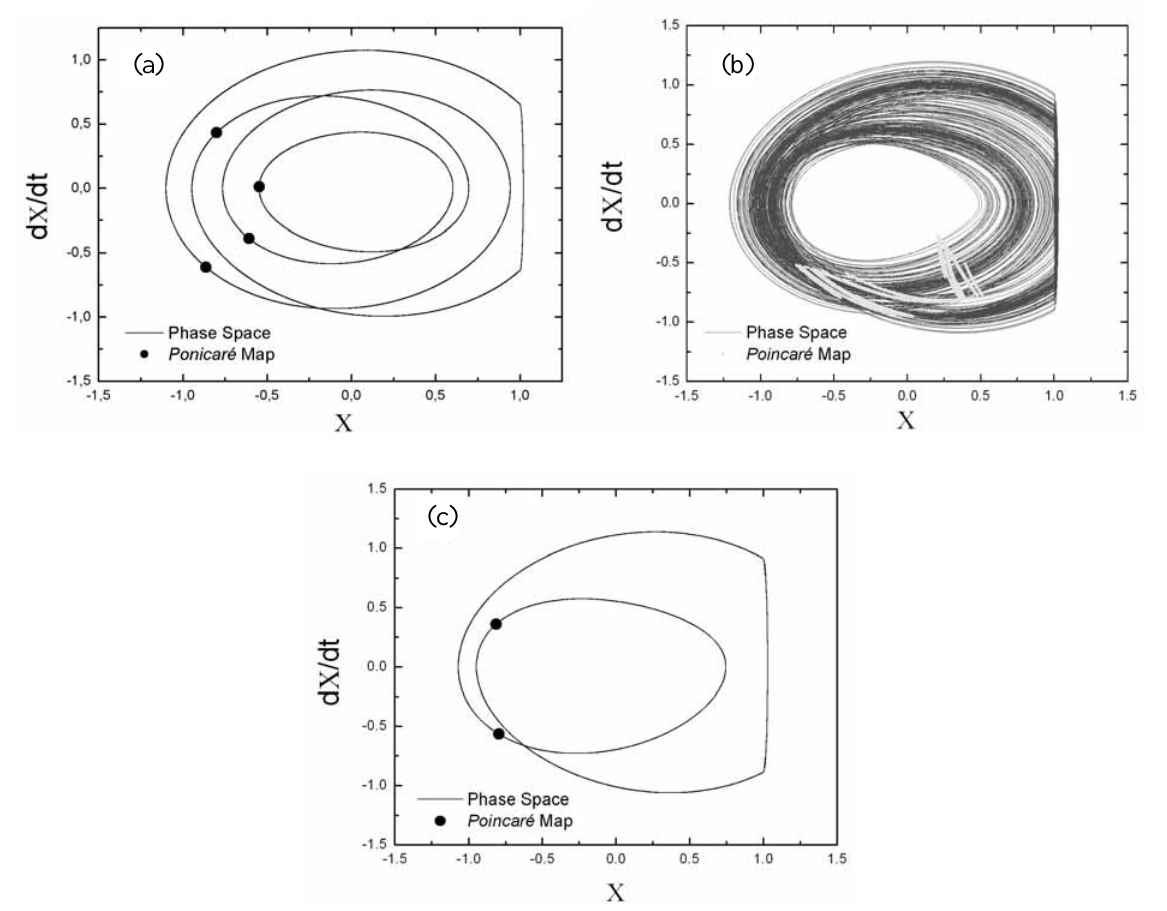
Fig. 12. Responses near the grazing orbit. (a) Period-4 ( F 0 = 0.225 s − 2 ) ; (b) Chaotic ( F 0 = 0.350 s − 2 ) ; (c) Period-2 ( F 0 = 0.400 s − 2 )